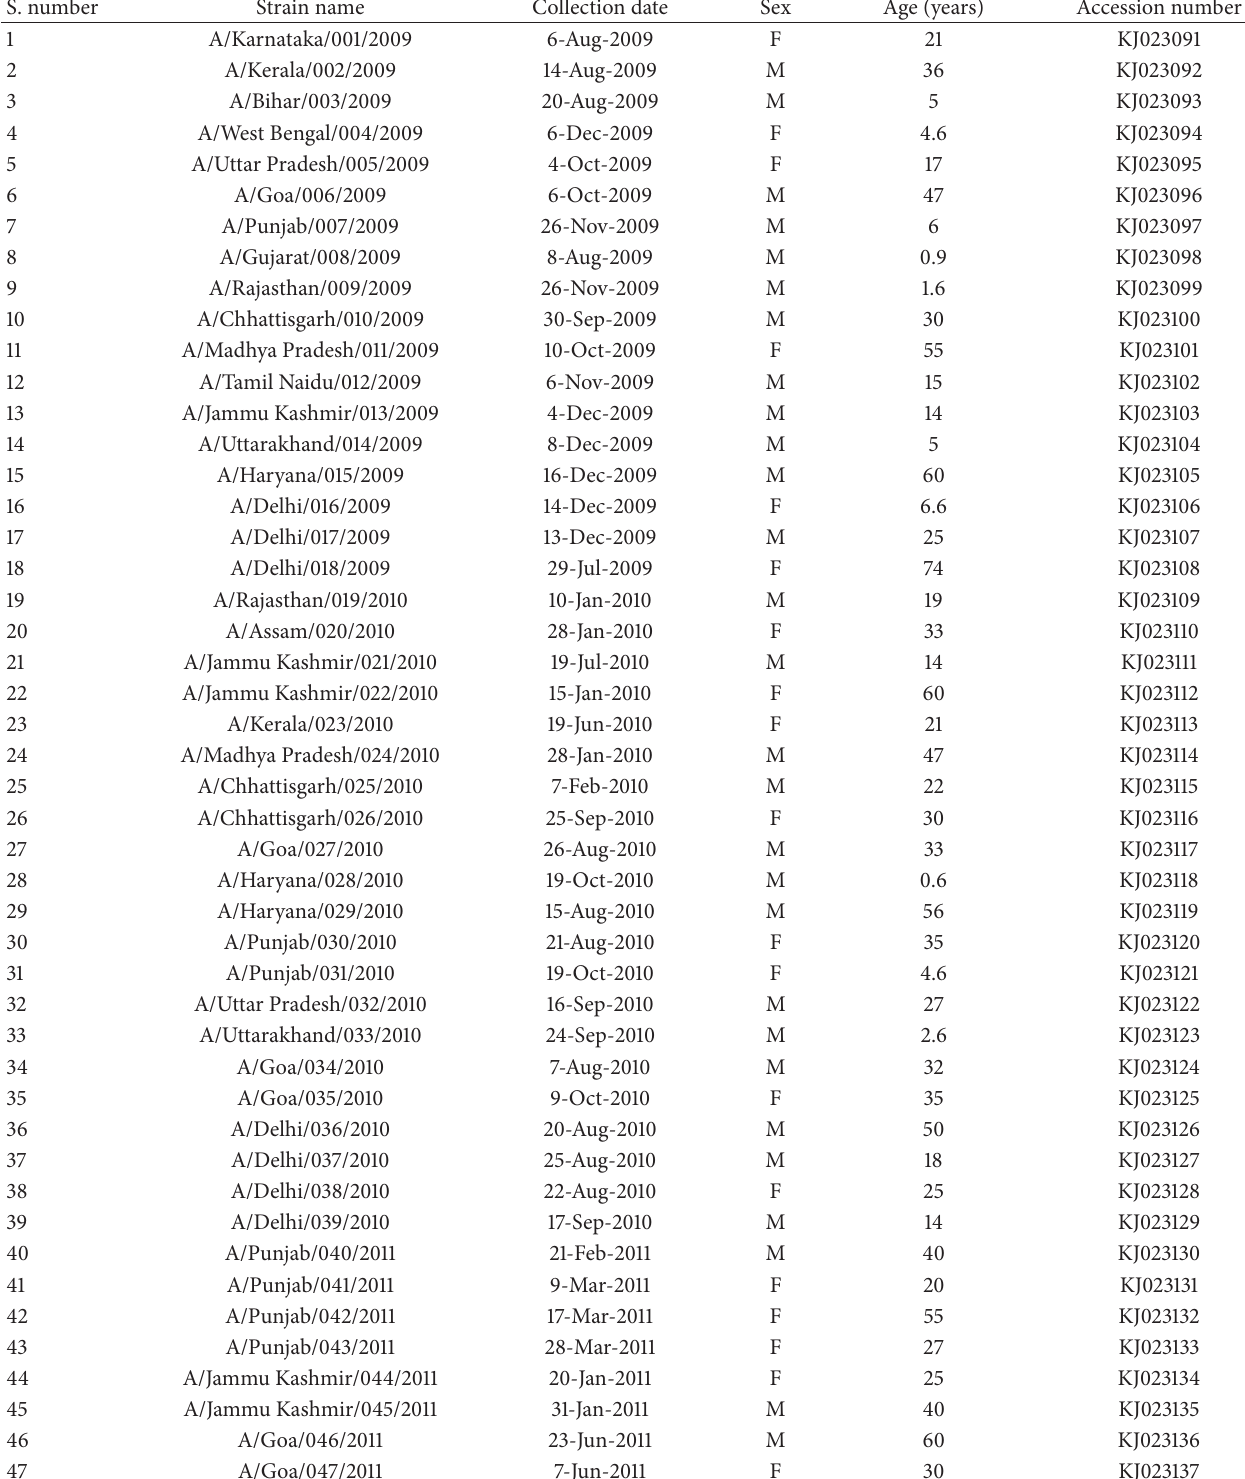
Table 1: Details of patients with strain name, collection date, and genes sequenced per strain with accession number. S.